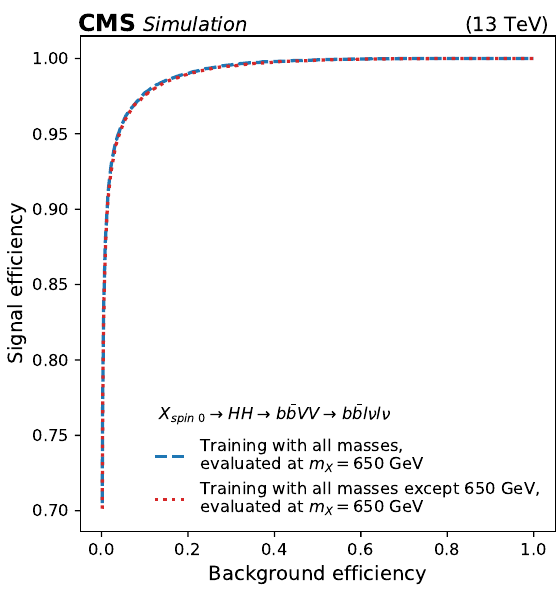
Figure 3 . Performance of the parameterised DNN for the resonant search, shown as the selection e(cid:14)ciency for the m X = 650 GeV signal as a function of the selection e(cid:14)ciency for the background (ROC curve), for the combined e + e (cid:0) , (cid:22) + (cid:22) (cid:0) and e (cid:6) (cid:22) (cid:7) channels. The dashed line corresponds to the DNN used in the analysis, trained on all available signal samples, and evaluated at m X = 650 GeV. The dotted line shows an alternative DNN trained using all signal samples except for m X = 650 GeV, and evaluated at m X = 650 GeV. Both curves overlap, indicating that the parameterised DNN is able to generalise to cases not seen during the training phase by interpolating the signal behaviour from nearby m X